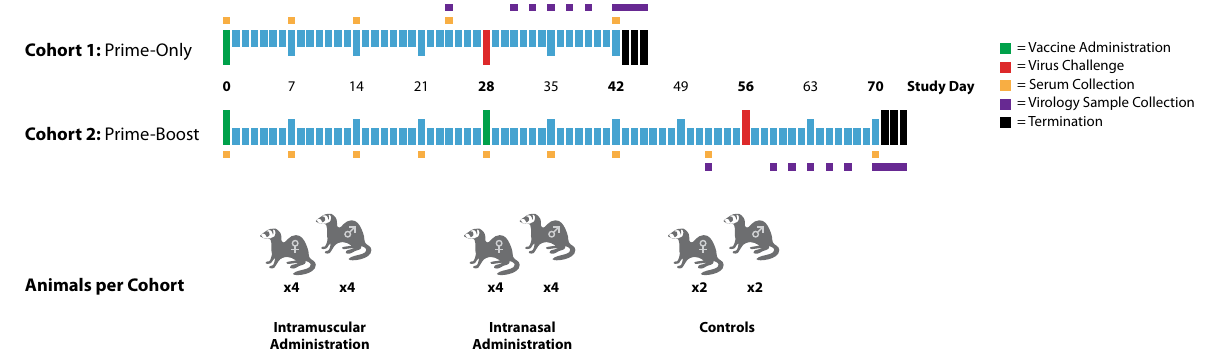
Fig. 1 Study Outline. Groups of eight ferrets (four male, four female) received either a single (prime) or two (prime-boost) doses of ChAdOx1 nCoV-19 via the intramuscular or intranasal route. An additional four ferrets (two male, two female) were included as mock (PBS) vaccinated control animals. Samples were collected from all of the animals at the timepoints